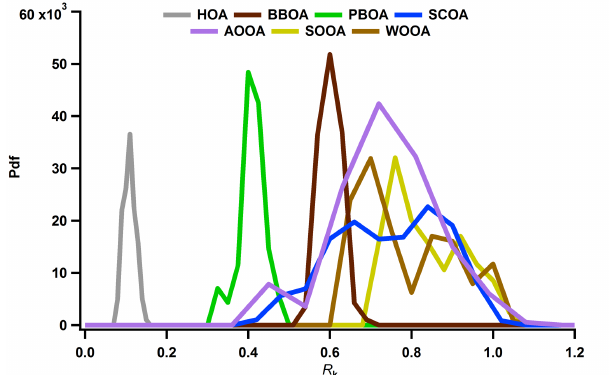
Figure 4. Probability density functions of factor recoveries: hydrocarbon-like OA (HOA) in grey, biomass burning OA (BBOA) in dark brown, sulfur-containing OA (SCOA) in blue, primary biological OA (PBOA) in green, anthropogenic oxygenated OA (AOOA) in purple, summer oxygenated OA (SOOA) in yellow and winter oxygenated OA (WOOA) in light brown.